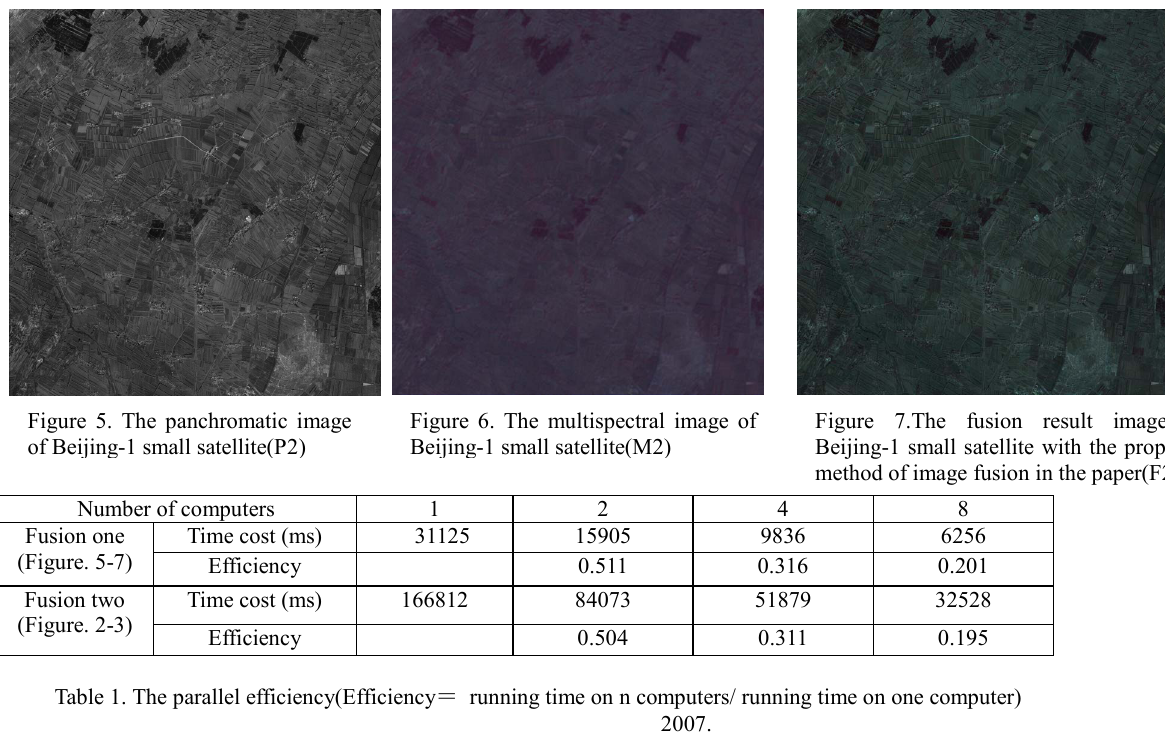
Table 1. The parallel efficiency(Efficiency ＝ running time on n computers/ running time on one computer)